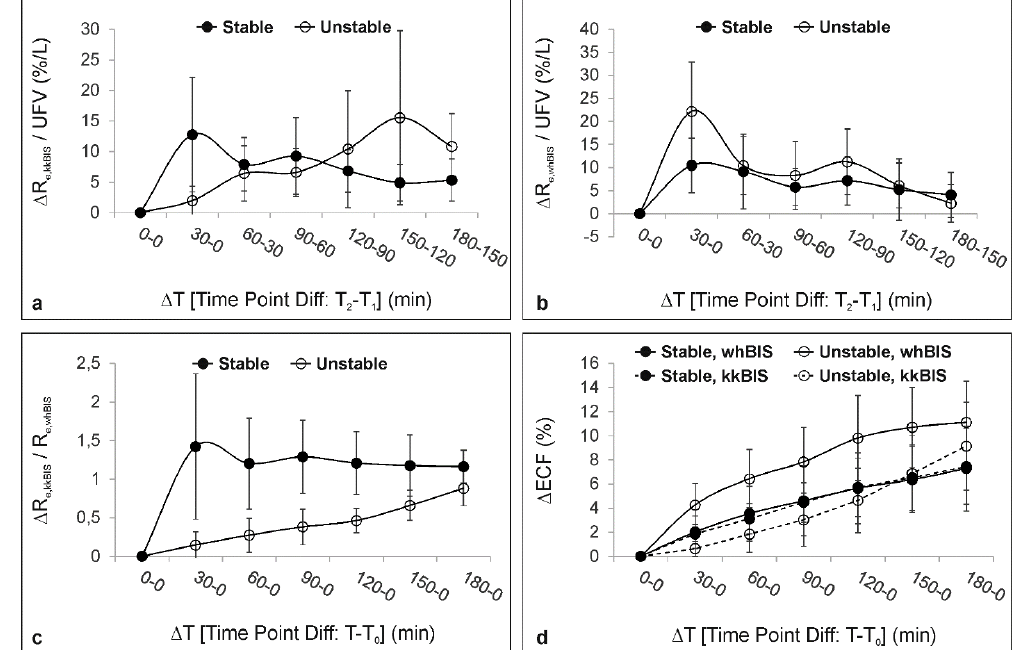
Fig.3: Graphs showing the trends (mean±SD) in the patient groups for (a) relative change in knee-to-knee extracellular resistance (∆R e,kkBIS ), (b) relative change in total body extracellular resistance (∆R e,whBSI ), both normalized by UFV (removed during the corresponding time interval), (c) the ratio of ∆R e,kkBIS to ∆R e,whBIS , and (d) the relative changes in extracellular fluid (∆ECF, %) measured by kkBIS and whBIS during the time course of the